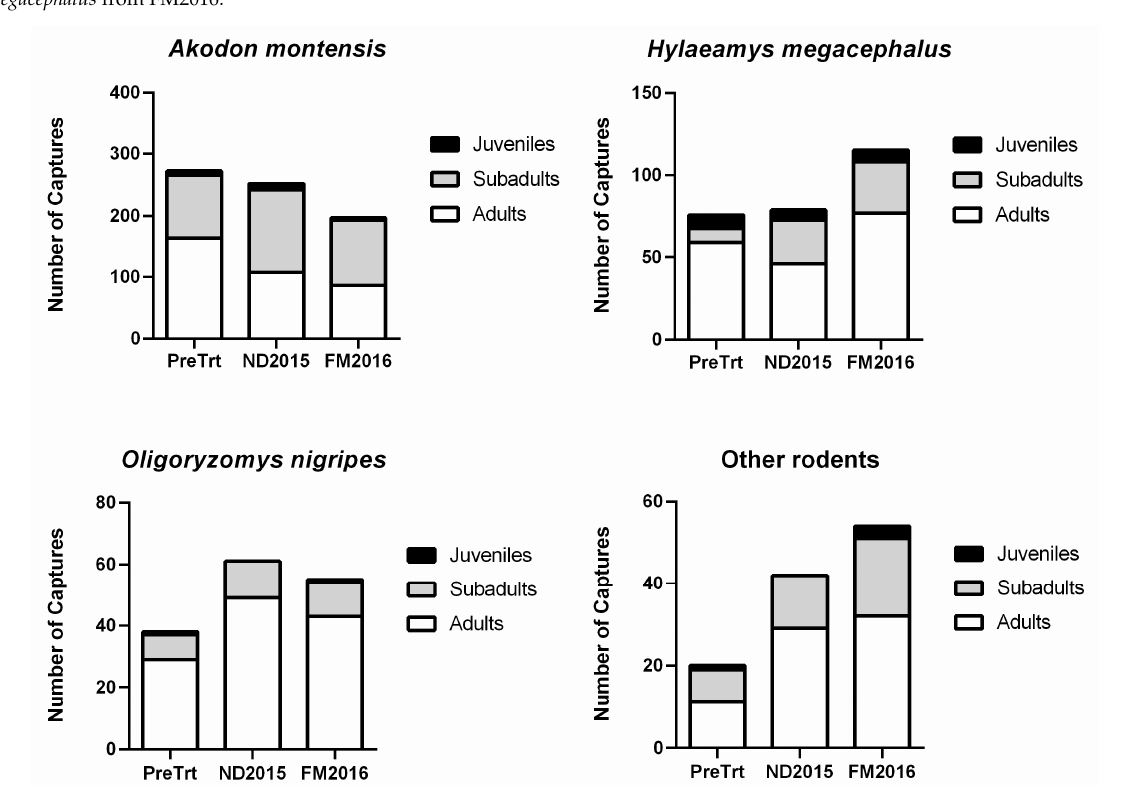
Figure 2. The number of unique captures by age class per session for the three most abundant species and other rodents. The first mark–release–recapture (MRR) session was pre-treatment (PreTrt) sampling performed June–July 2015, which was followed by one post-treatment sampling by MRR conducted November–December 2015 (ND2015) and a second post-treatment sampling by capture conducted February–March 2016 (FM2016). Juveniles are shaded in black, sub-adults are shaded in light gray, and adults are shown in white.